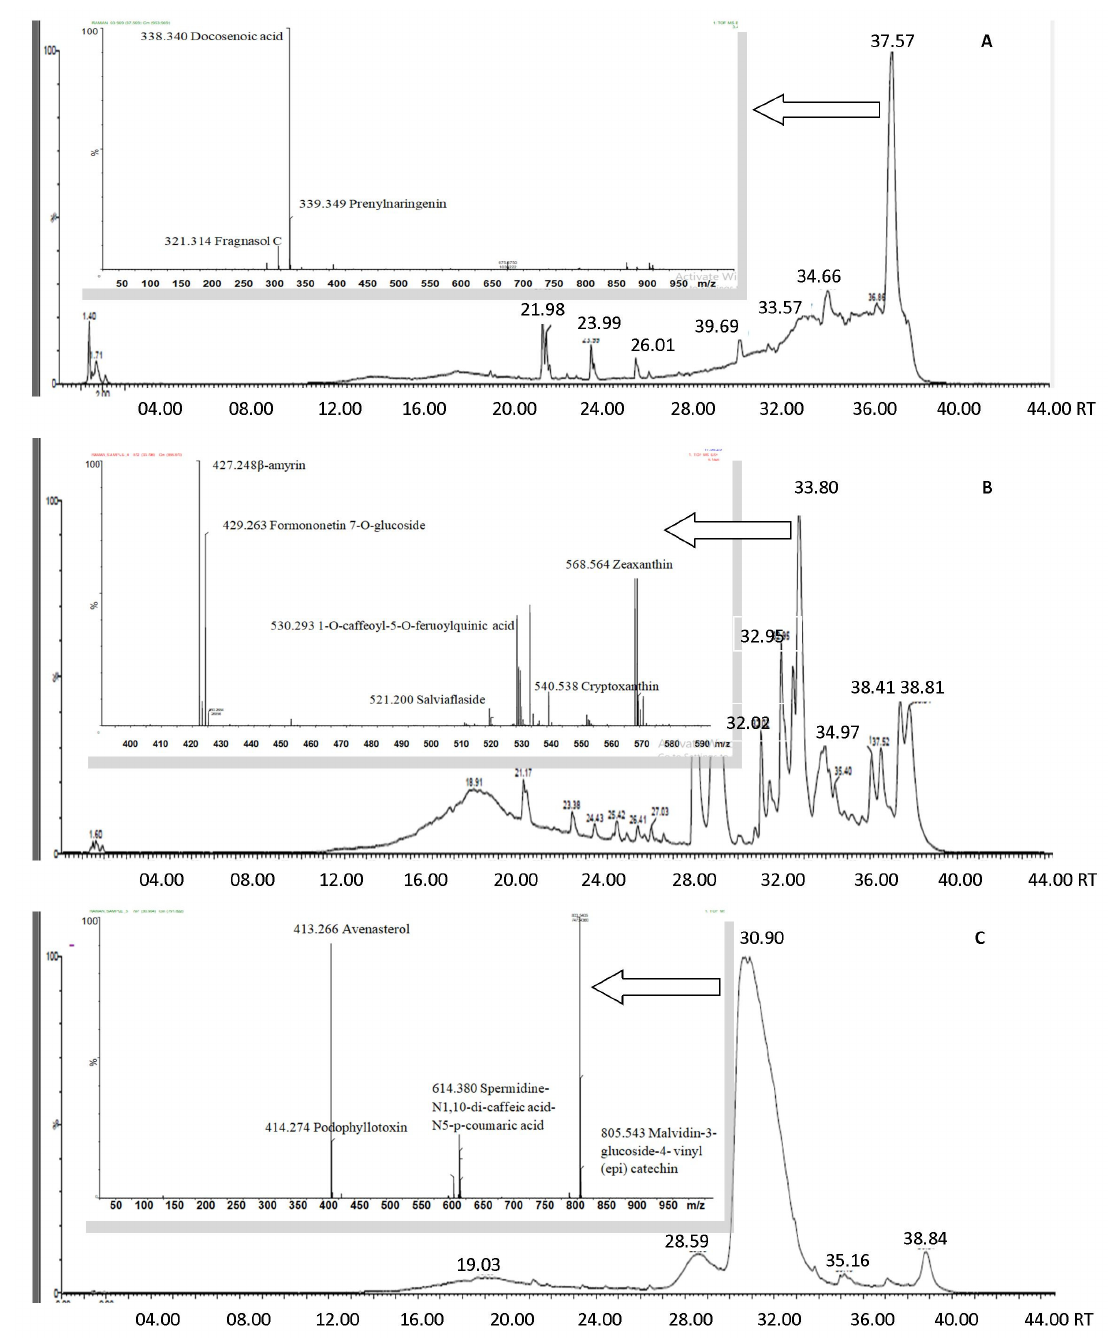
Figure 1. LC-MS-MALDI-TOF/TOF chromatograms of ( A ) wheatgrass juice, ( B ) wheatgrass juice after primary fermentation, and ( C ) wheatgrass juice after secondary fermentation. The x-axis denotes retention time (min) and y-axis denotes percentage intensity. Inset pictures show identified compounds in respective